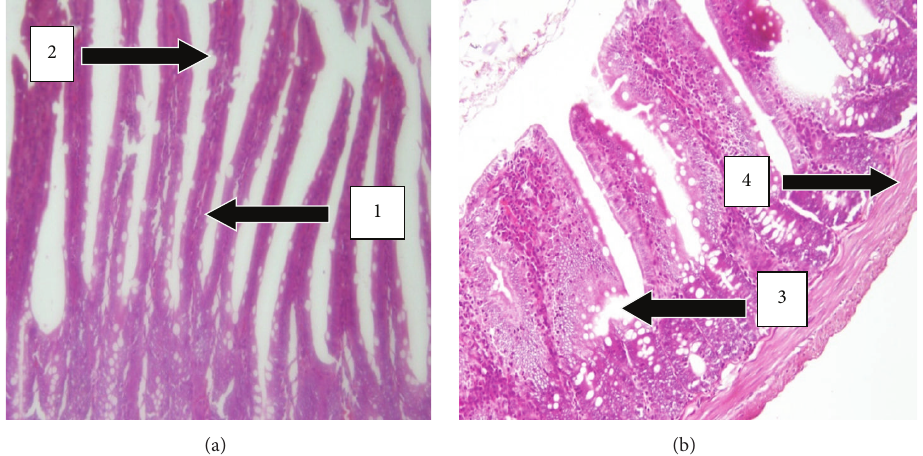
Figure 8: H&E stained sections of the small intestines at 20x magnification. (a) Small intestine sections of control male SD rats showing normal histology. Note the presence of the villi (1) , goblet cells which produces mucus (2) , and basement membrane with no proliferation (4). (b) Small intestine section of the UNCP treated male SD rats (2000 mg/kg) showing moderate changes and erosion of the mucosal lining of the villi (3)